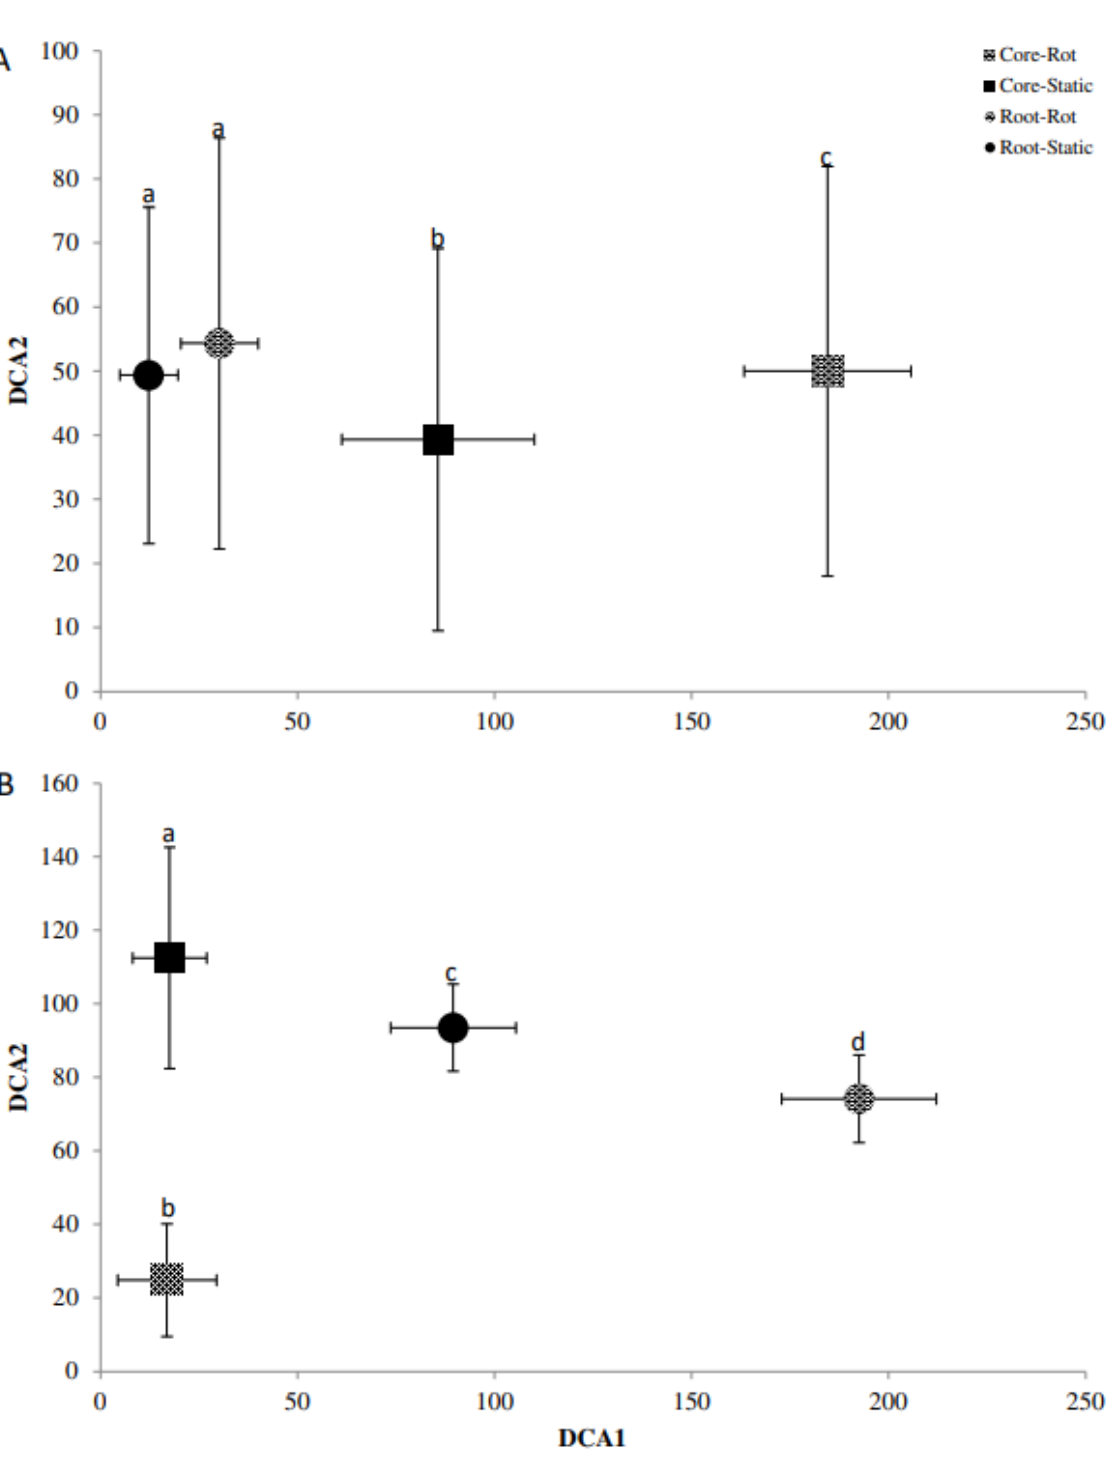
Figure 4. Detrended correspondence analysis (DCA) bi-plot of the fungal ITS community fingerprint for Agrostis stolonifera ( A ) and Plantago lanceolata ( B ). DCA1 = Axis 1, DCA2 = Axis 2. Treatments; roots = circle, cores = square, static (Static) = solid, rotating (Rot) = pattern. Letters (a–d) indicate significant differences; error bars represent standard deviation among replicates.